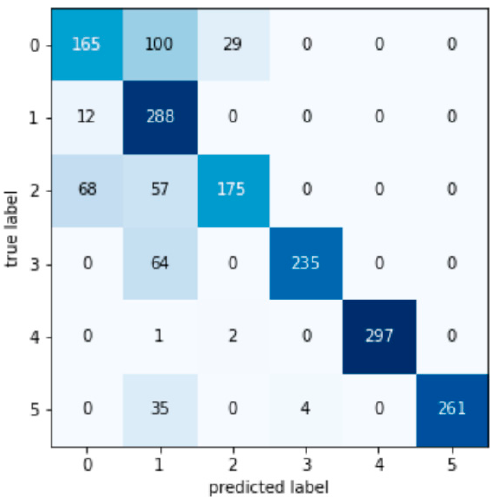
Figure A1. KNN confusion matrix.